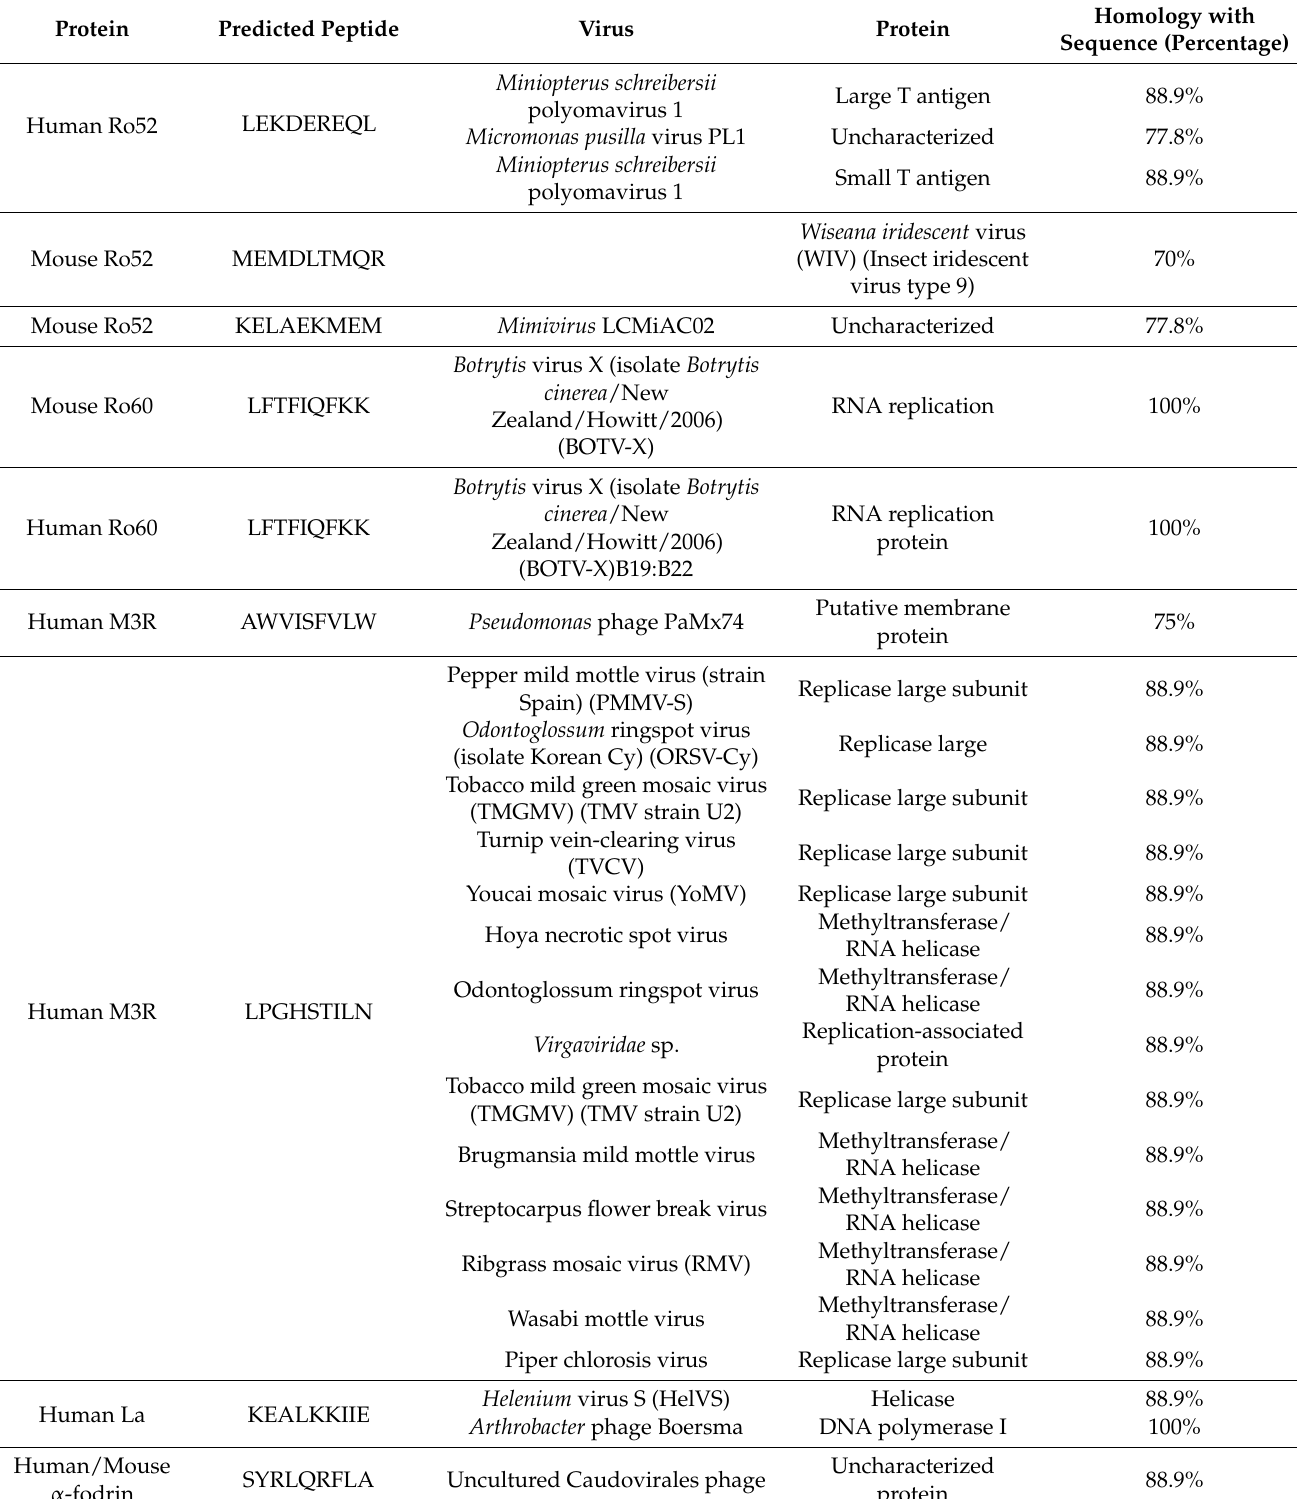
Table 14. Homology of predicted peptides binding to HLA-DRB1*03:01 to viral proteins.